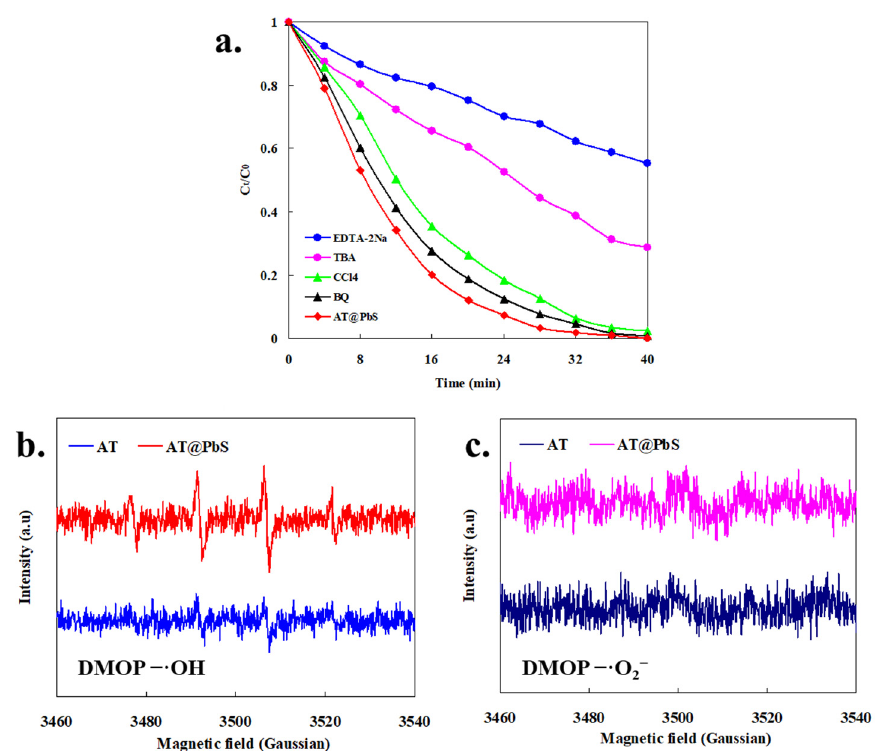
Figure 11. ( a ) The MB (methylene blue) photocatalytic efficiencies after the addition of capturing agents, ( b ) ESR (Electron Paramagnetic Resonance) spectra of radical adducts trapped by DMPO (5,5-dimethyl-1-pyrroline N-oxide) under the irradiation of visible light for DMPO- • OH (the combination of 5,5-dimethyl-1-pyrroline N-oxide and OH), ( c ) ESR (Electron Paramagnetic Resonance) spectra of radical adducts trapped by DMPO (5,5-dimethyl-1-pyrroline N-oxide) under the irradiation of visible light for DMPO- • O 2 − (the combination of 5,5-dimethyl-1-pyrroline N-oxide and O 2 ).